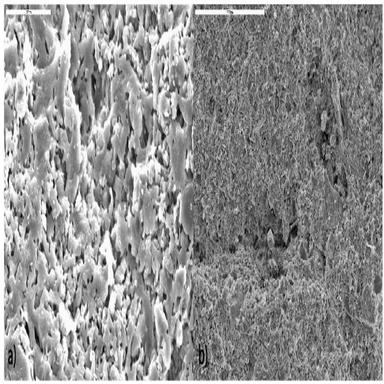
The micrograph of the fracture section of the samples: a) without fibers, b) with 2 wt % of fibers embedded into the structure of the matrix.